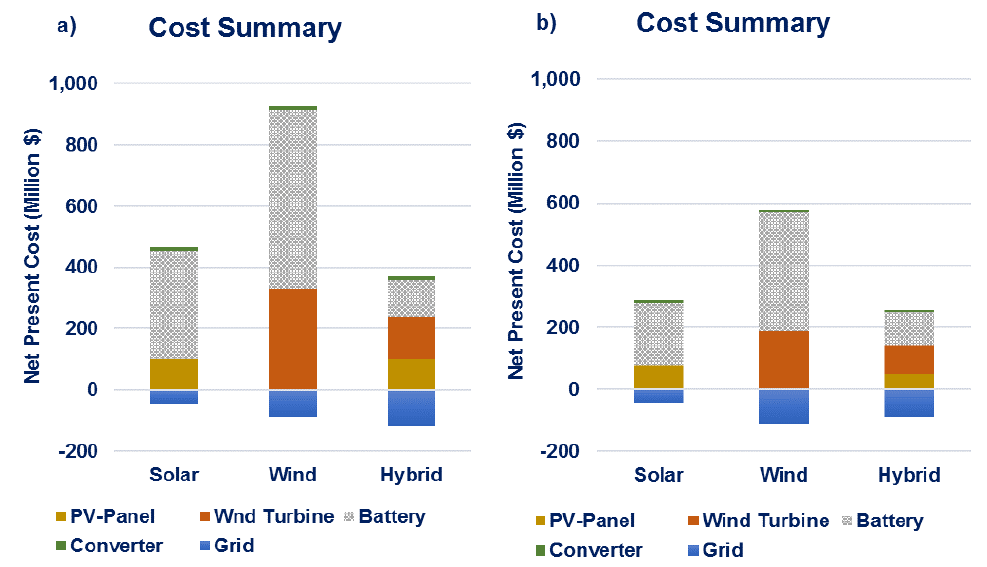
Figure 10. Cost summary of the optimized renewable power systems examined in scenario B: ( a ) Case-Kenya and ( b ) Case-South Africa.